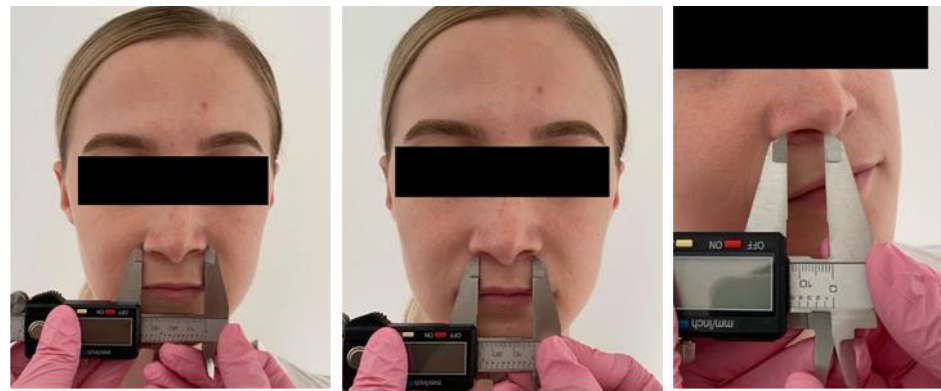
Figure 2. Mouth opening measurement.